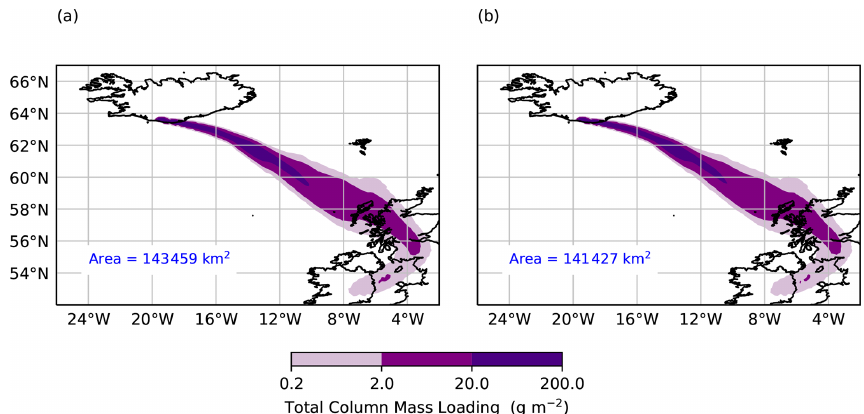
Figure 8. Modelled 1h averaged total column mass loadings of the Eyjafjallajökull ash cloud at 00:00UTC on 5 May 2010, using (a) the measured GSD of the non-aggregated ash and (b) the time-varying aggregated GSD. The measured density distribution of the non-aggregated ash grains is applied in both cases. The area of the ash cloud with mass loadings > 2gm − 2 , which is significant for aircraft operations, is shown.